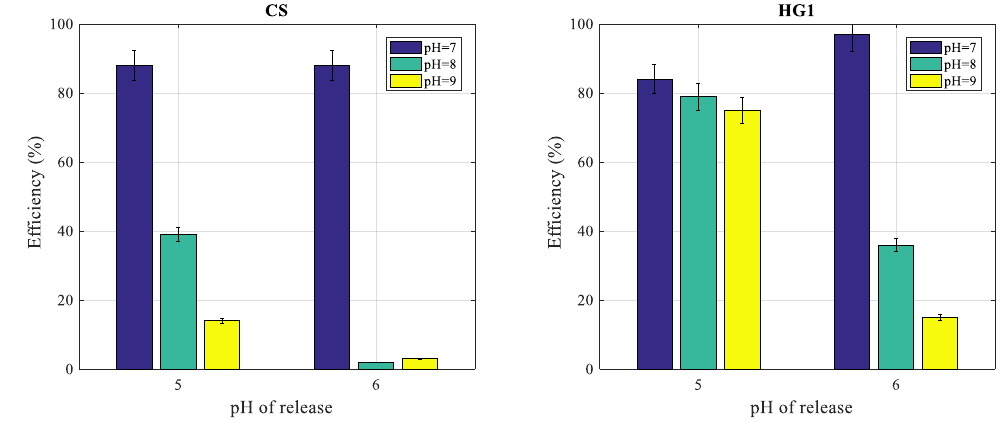
Figure 9. Effect of pH of fixing and that of salting out on protein release from CS (left) and HG1 (right) latexes. Conditions: phosphate buffers at different pH (5 and 6), temperature 20 °C, [Ni] = 10 –2 M. For CS (Figure 9, left), protein extraction after complexation at pH = 7 leads to 85% extraction efficiency at pH = 5 and pH = 6. Whereas, the complexation performed at pH = 8 or pH = 9 leads to low protein extraction yields at both releases pH (5 and 6).